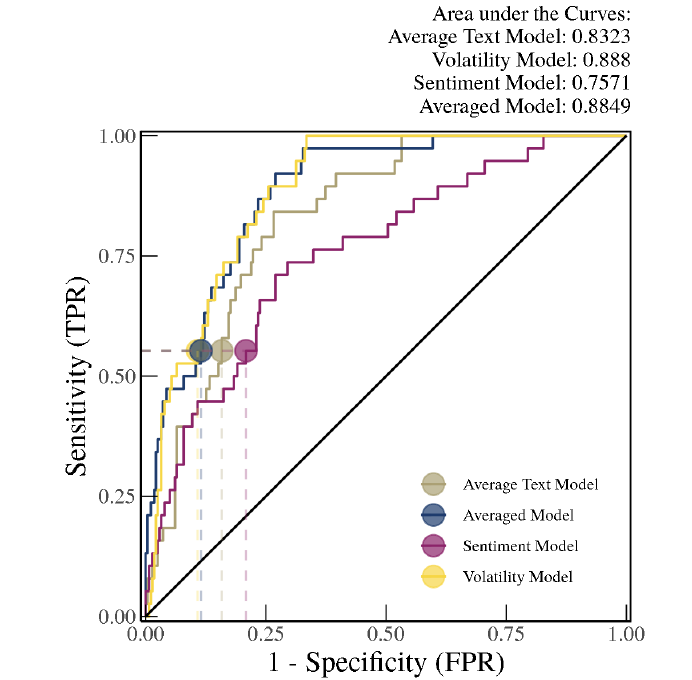
Figure 16. Results for LV Banking Crises on IMF Article IVs . Note: This figure shows the ROC curves for our out-of-sample period (2005–2017) for models trained on the period 1983–2004 using IMF Article IV text based on Laeven and Valencia (2013) banking crises. The results show that the Volatility Model performs best (AUC of 0.888), followed by the Averaged Model, the Average Text Model, and the Sentiment